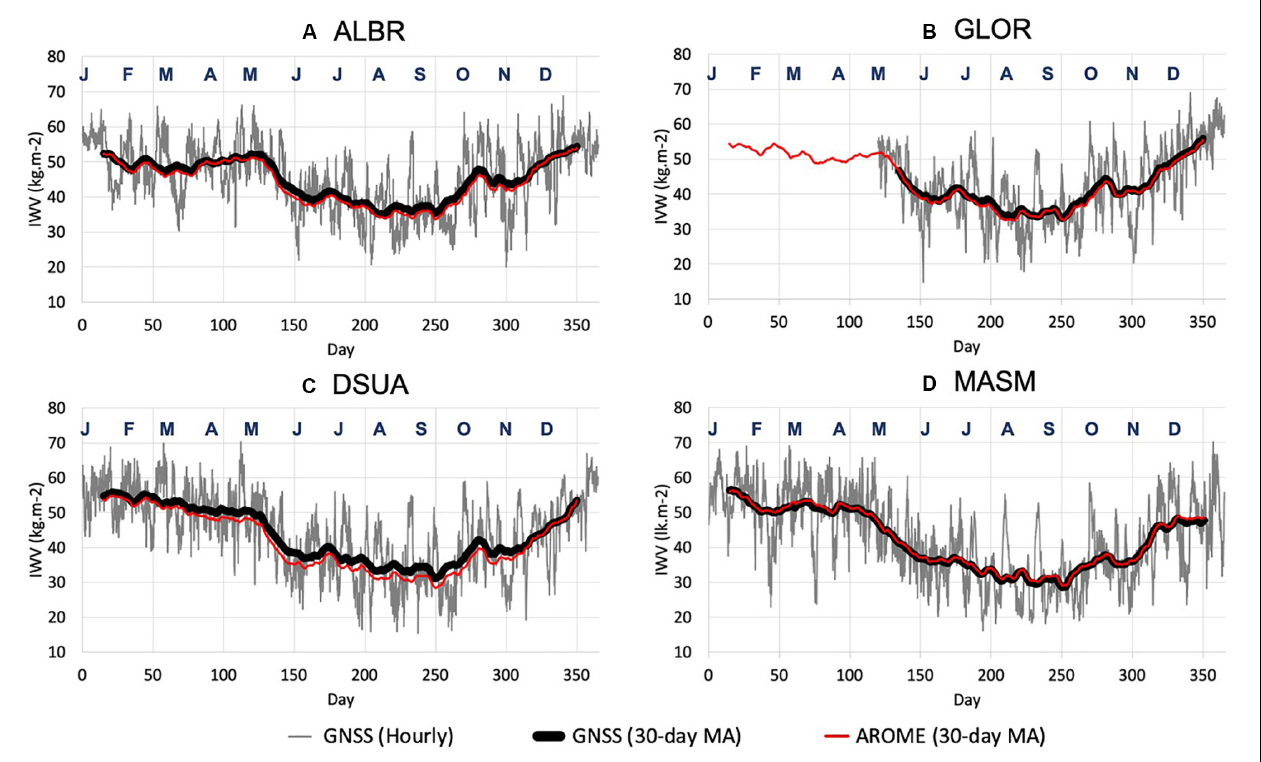
FIGURE 2 | Times series of hourly integrated water vapor content (kg.m - 2 ) as deduced from GNSS data collected at (A) Aldabra (ALBR), (B) Grande Glorieuse (GLOR), (C) Diego-Suarez (DSUA) and (D) Sainte-Marie (MASM) between 1 January and 31 December, 2019 (see Figure 1 for location). Black (resp. red) lines show the 30-day moving average (+/– 15 days) of GNSS (resp. AROME-IO) IWV times series. Note that continuous times series of tropospheric GNSS data at GLOR are only available since May